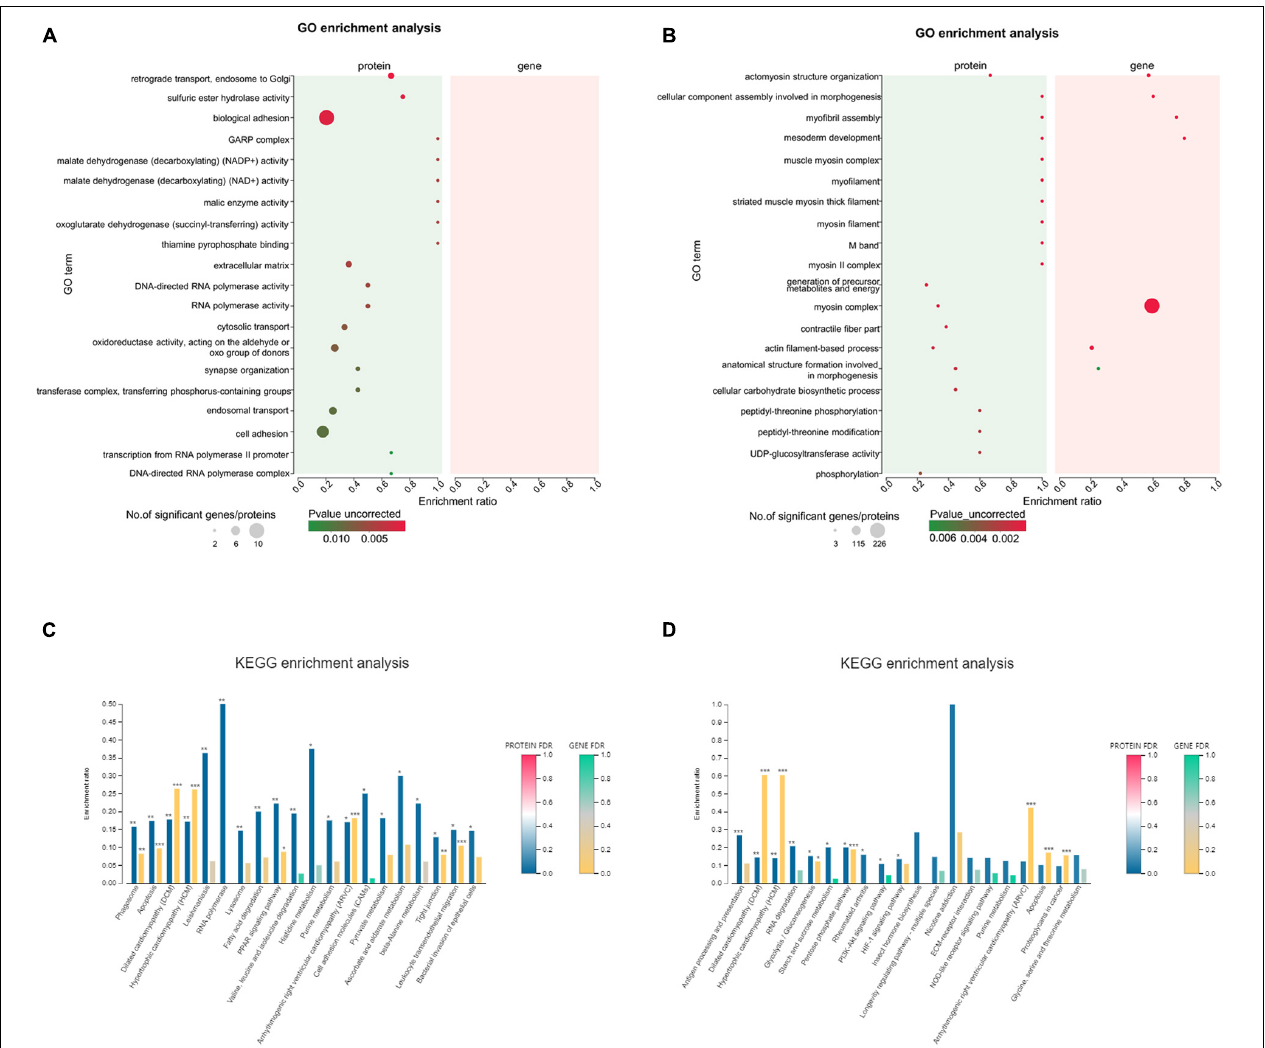
FIGURE 10 | The top 20 GO terms and KEGG pathways significantly enriched in differentially expressed genes (DEGs)/differentially expressed proteins (DEPs). (A,B) Integrated GO term enrichment analysis of DEGs and DEPs for the intracellular protein fraction. (C,D) Integrated KEGG pathway enrichment analysis of DEGs and DEPs for the intracellular protein fraction. *FDR < 0.05; **FDR < 0.01; ***FDR <